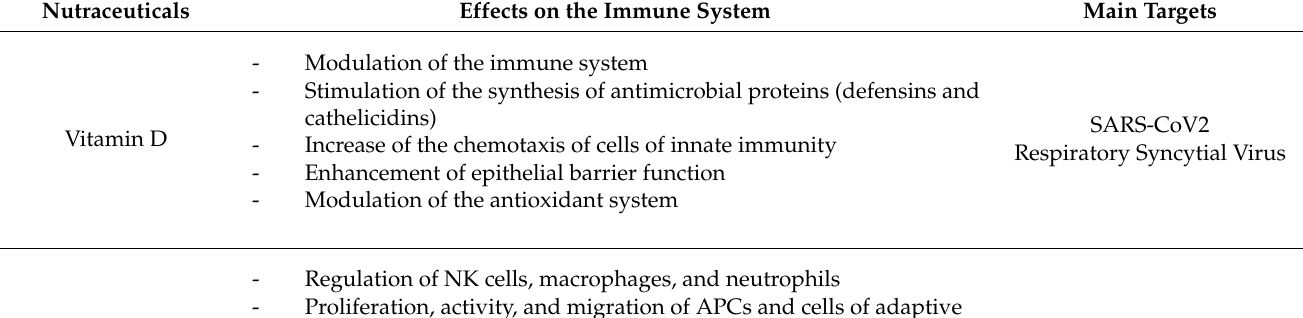
Table 1. Nutraceuticals and their relative antimicrobial